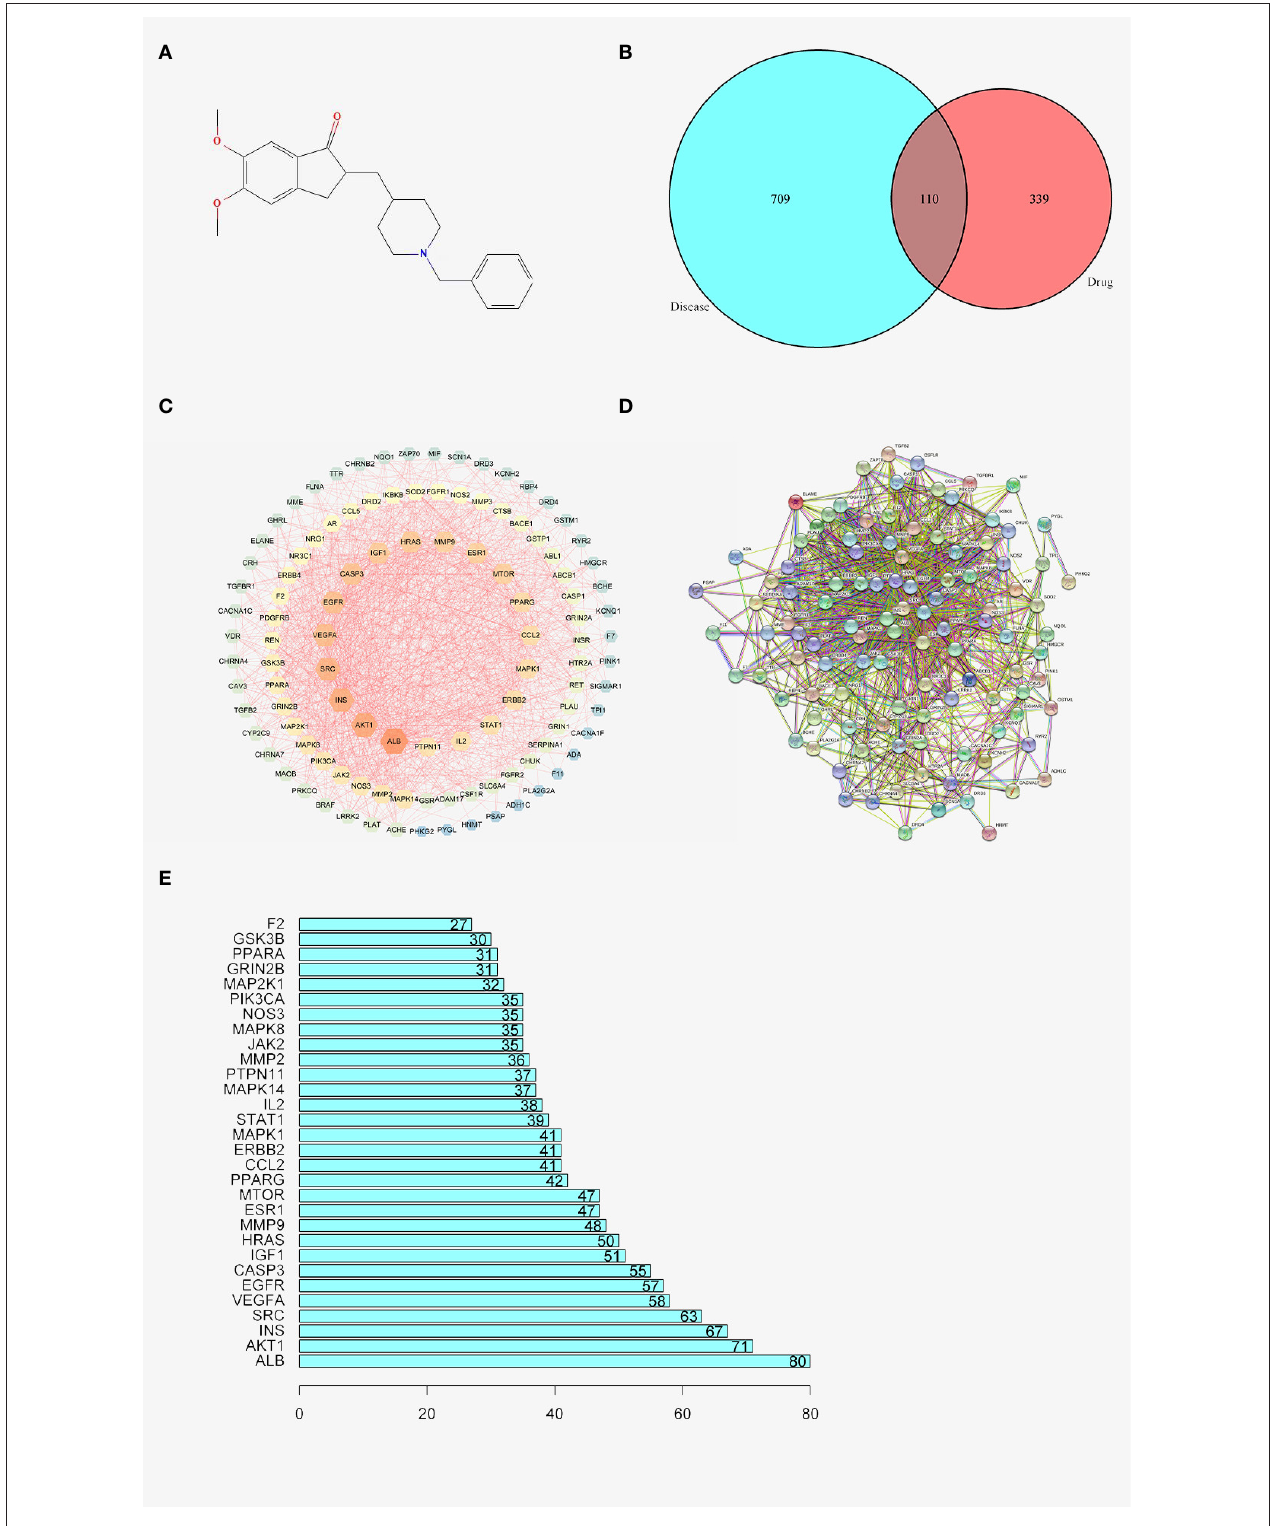
FIGURE 1 | (A) 2D structure of DNP. (B) Venn graph of AD and DNP. (C) Diseases- drug-active ingredient-key target network. (D) PPI network. (E) Bar chart of 30 core genes.